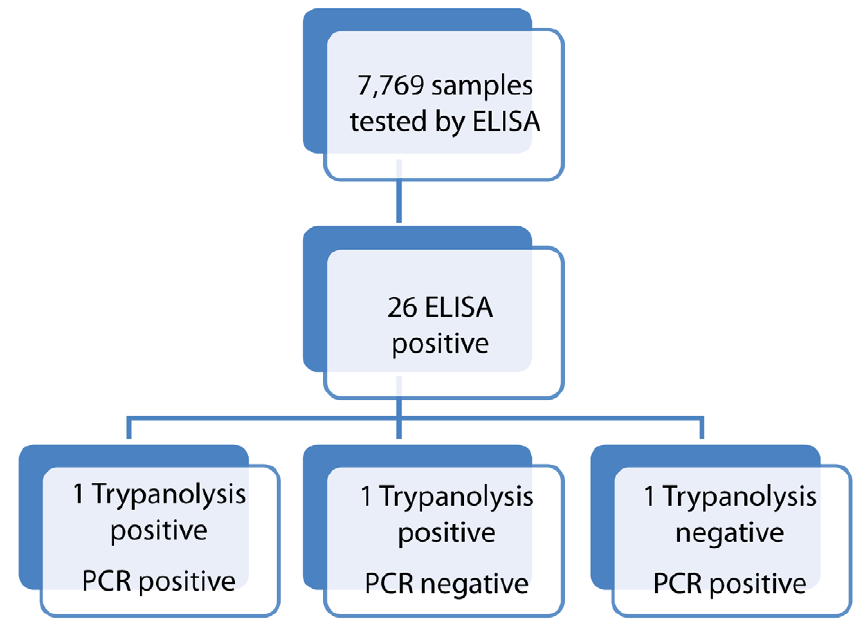
Figure 2. Flow chart showing processing of samples.